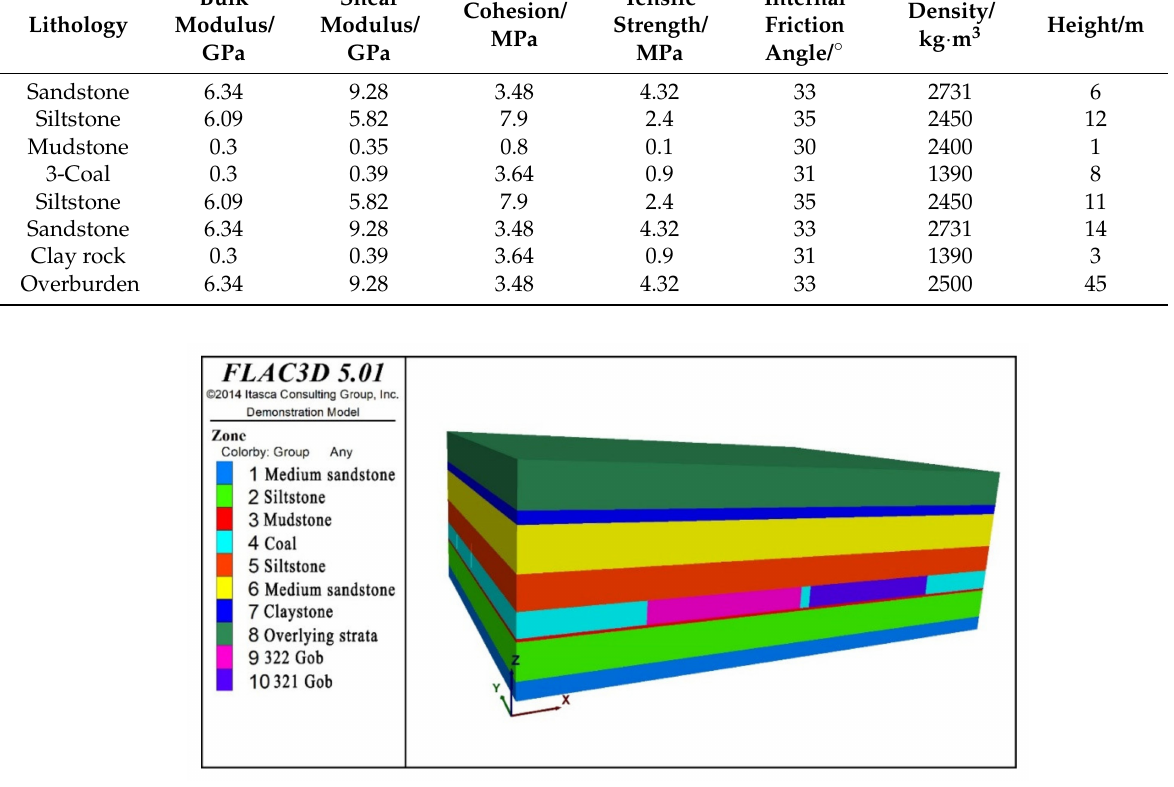
Figure 7. FLAC3D modeling of irregular